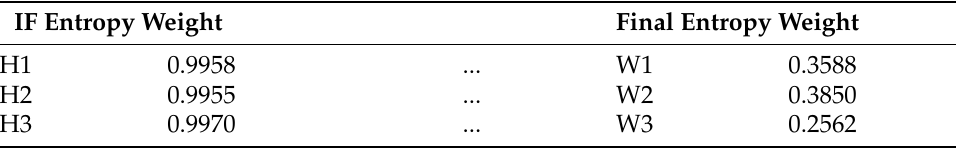
Table 8. IF entropy weights and final entropy weight for main